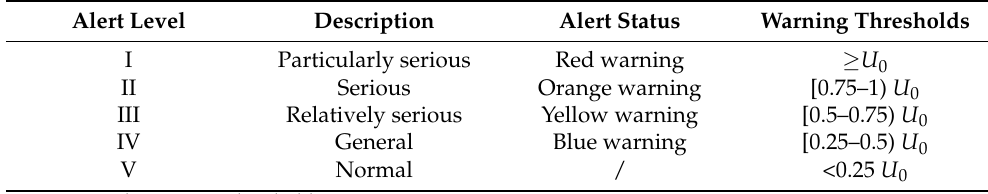
Table 4. The unified graded warning thresholds for monitored components of underwater tunnel (revised according to Table 6.6.8 in